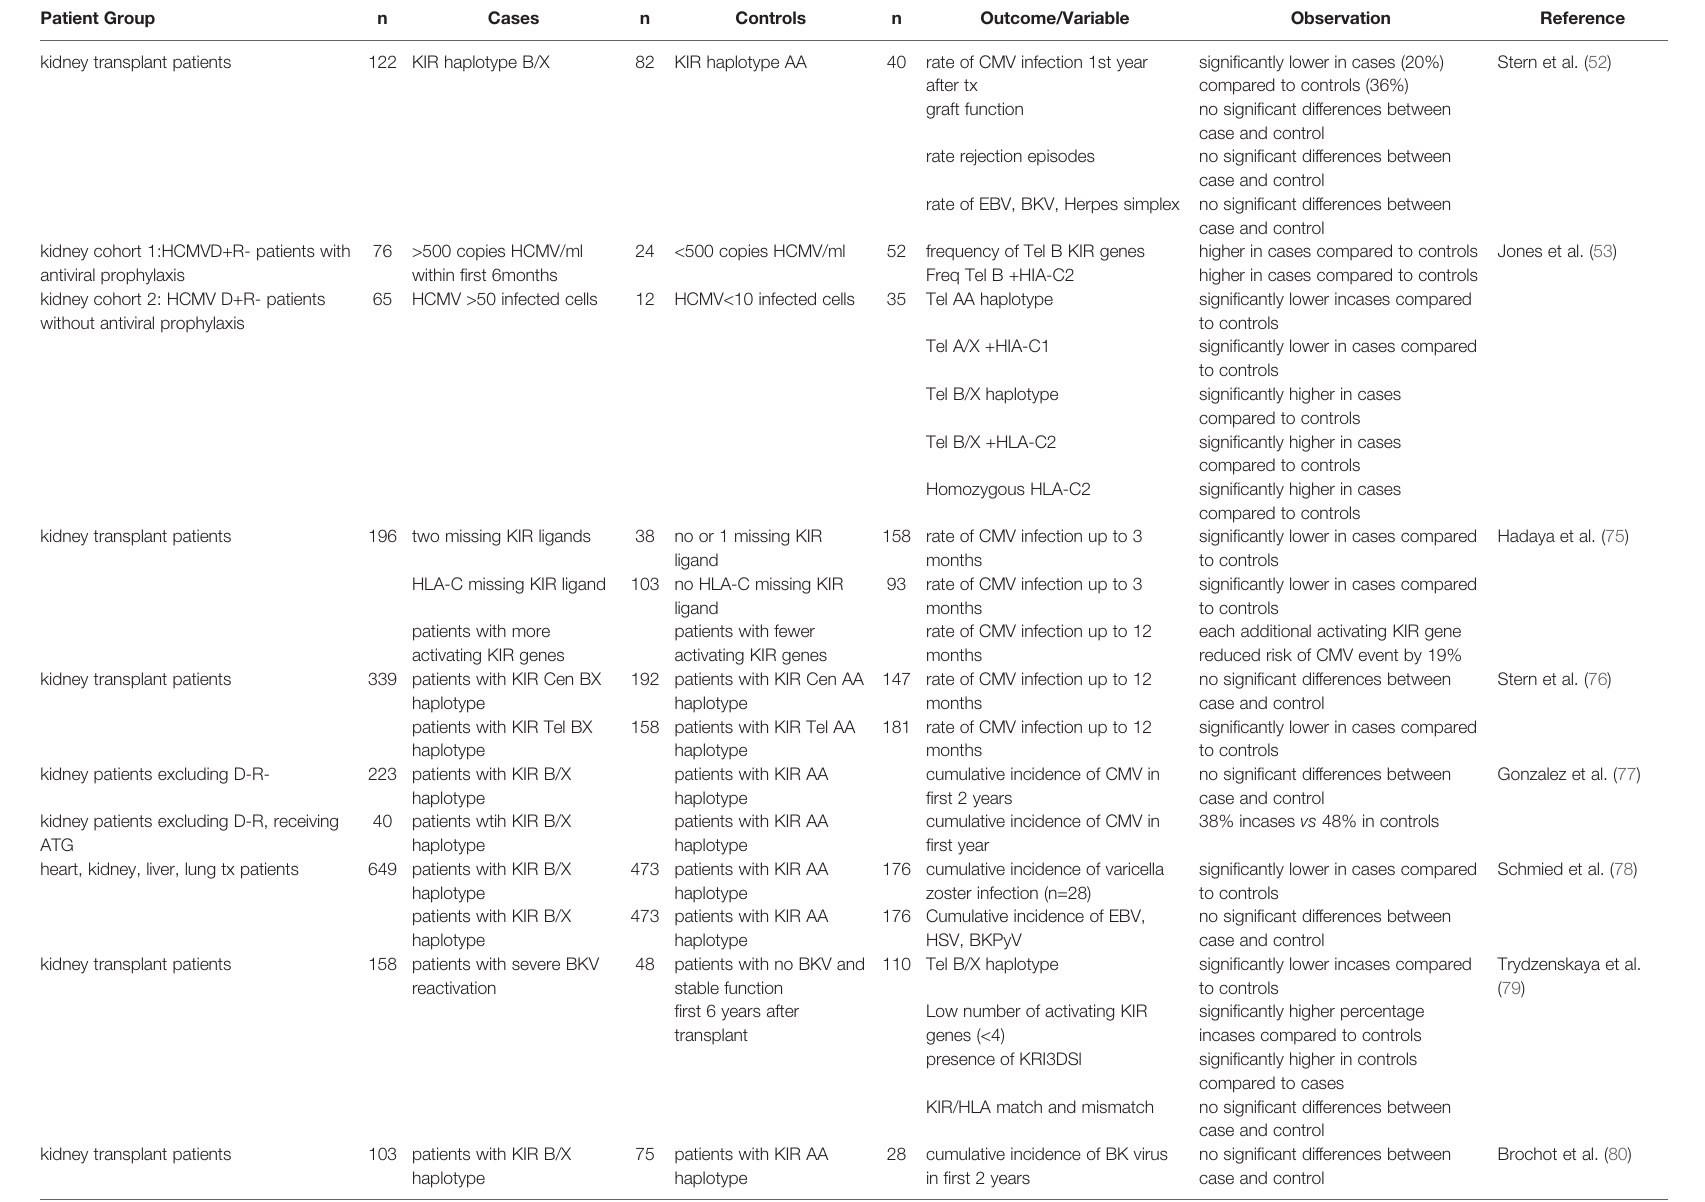
TABLE 2 | Overview of published studies investigating the impact of KIR and KRI-ligand on viral infections after solid organ